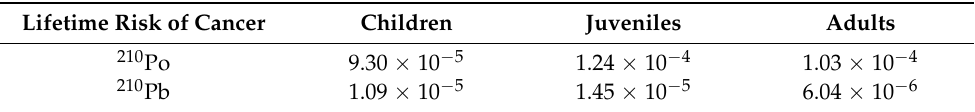
Table 4. Lifetime risk of cancer levels associated with the direct intake of 210 Pb and 210 Po in seafood